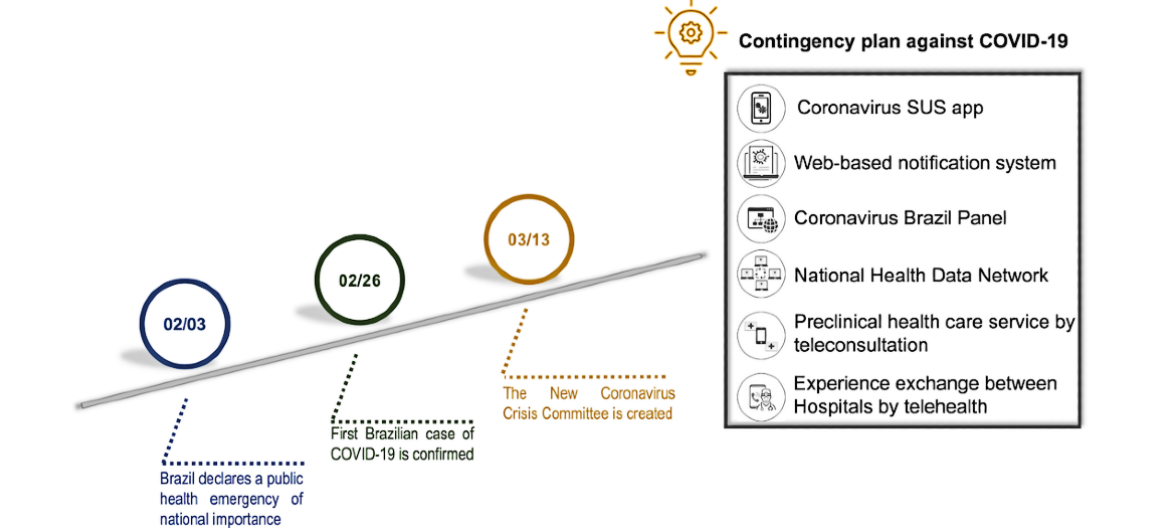
Figure 1. The digital health strategies deployed in Brazil in response to COVID-19. SUS: Sistema Único de Saúde (Unified Health